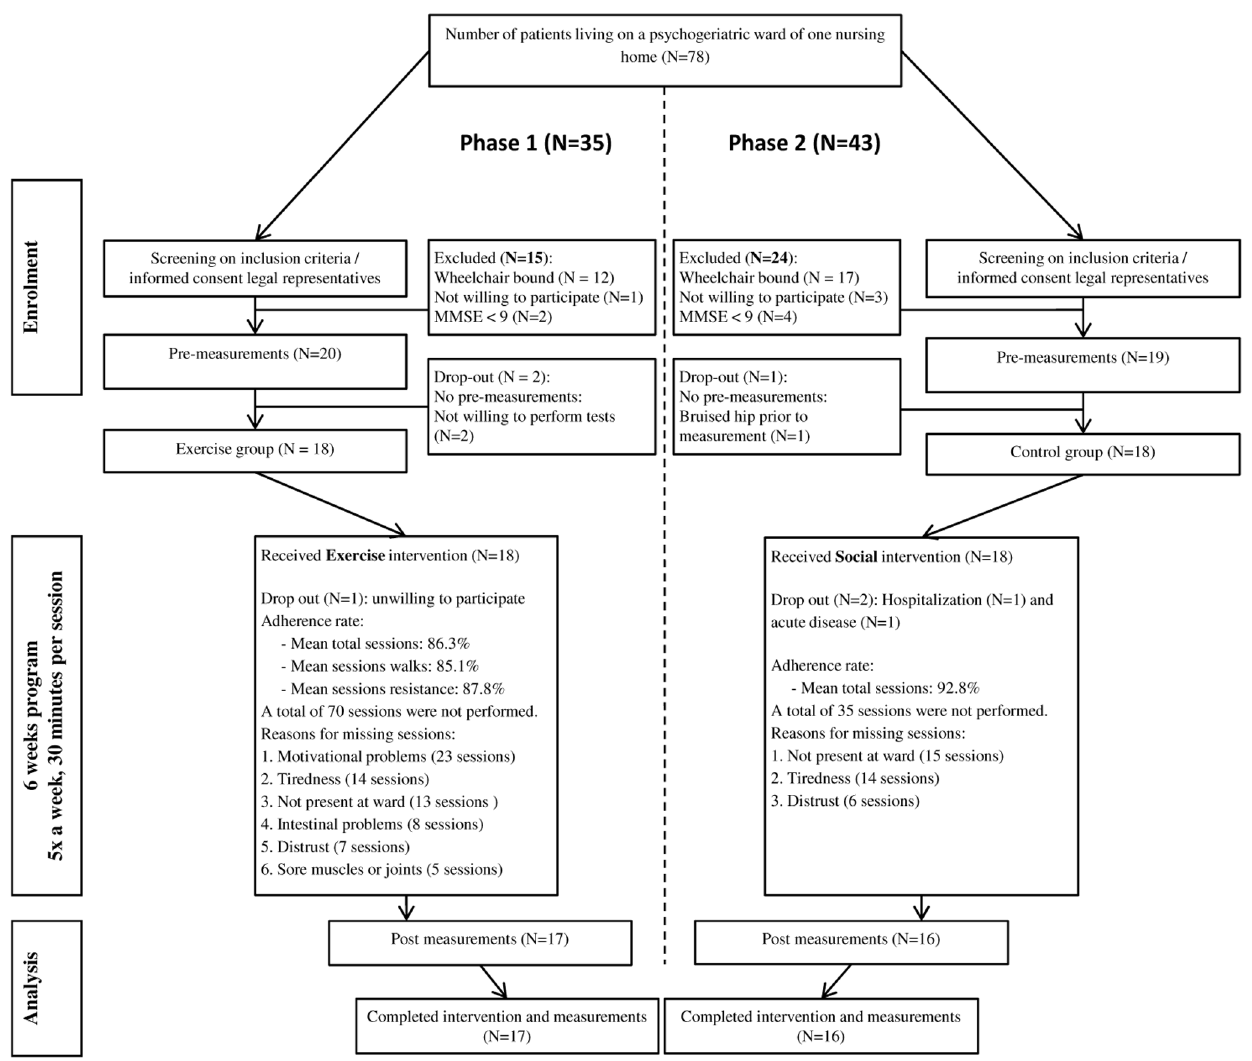
Figure 1. Flowchart of the study. Phase 1 (left side) determined feasibility by including a combined exercise group. Phase 2 (right side) explored the effects of the program by including a social visits group.